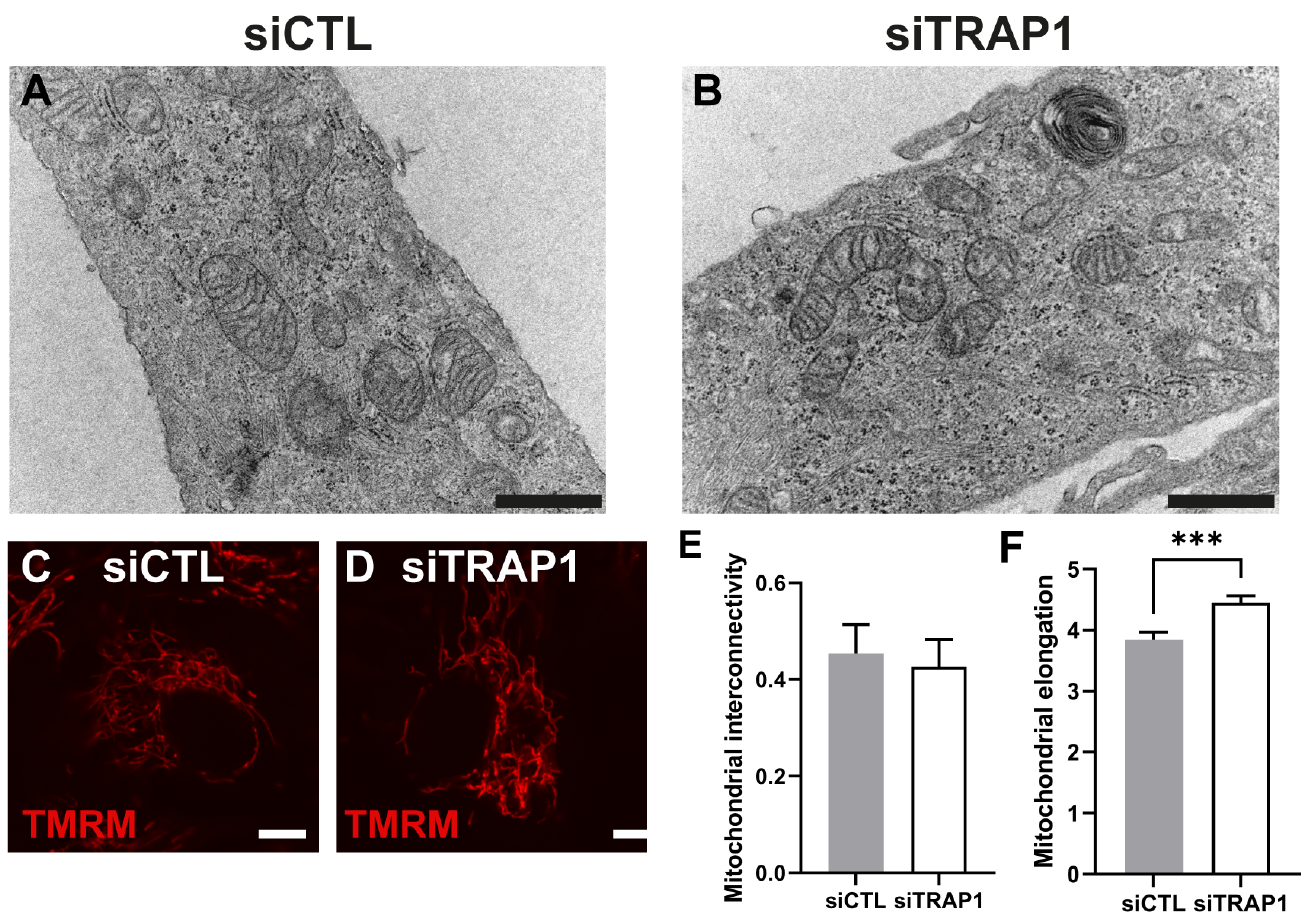
Figure 5. TRAP1 silencing increases mitochondrial elongation without affecting mitochondrial ultrastructure. Transmission electron microscopy (TEM) images of mitochondria from ARPE-19 cells transfected with siCTL ( A ) or siTRAP1 ( B ). Representative mitochondria are presented. Scale bars in A and B: 100 nm. Analysis of confocal microscopy images obtained using Image-iT™ TMRM Reagent (TMRM) for mitochondrial labelling in ARPE-19 cells transfected with siCTL ( C ) or siTRAP1 ( D ). Scale bars in C and D: 50 µ m. The mitochondrial interconnectivity was similar between the two experimental groups ( E ). siTRAP1 cells showed increased mitochondrial elongation ( F ). Statistical significance was calculated by using an unpaired t-test. Statistically significant values: *** p < 0.001. In the graphs, all values are expressed as mean ± standard error of the mean